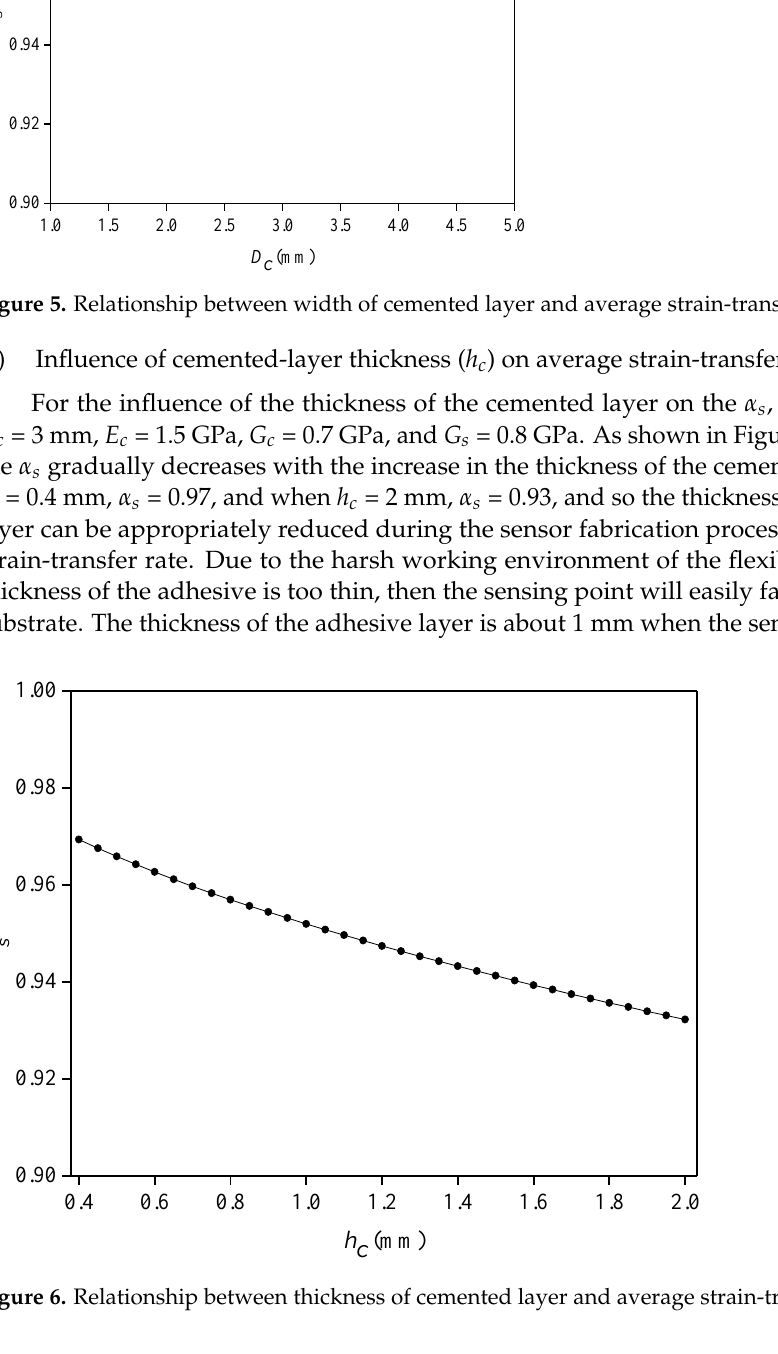
G s (GPa) Figure 7. Relationship between shear modulus and average strain-transfer coefficient.